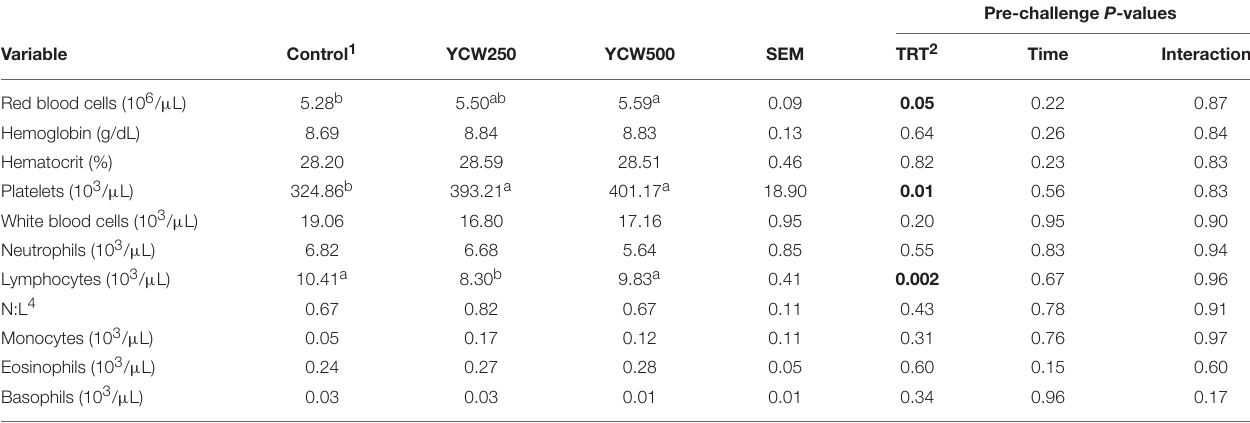
Pre-challenge P -values